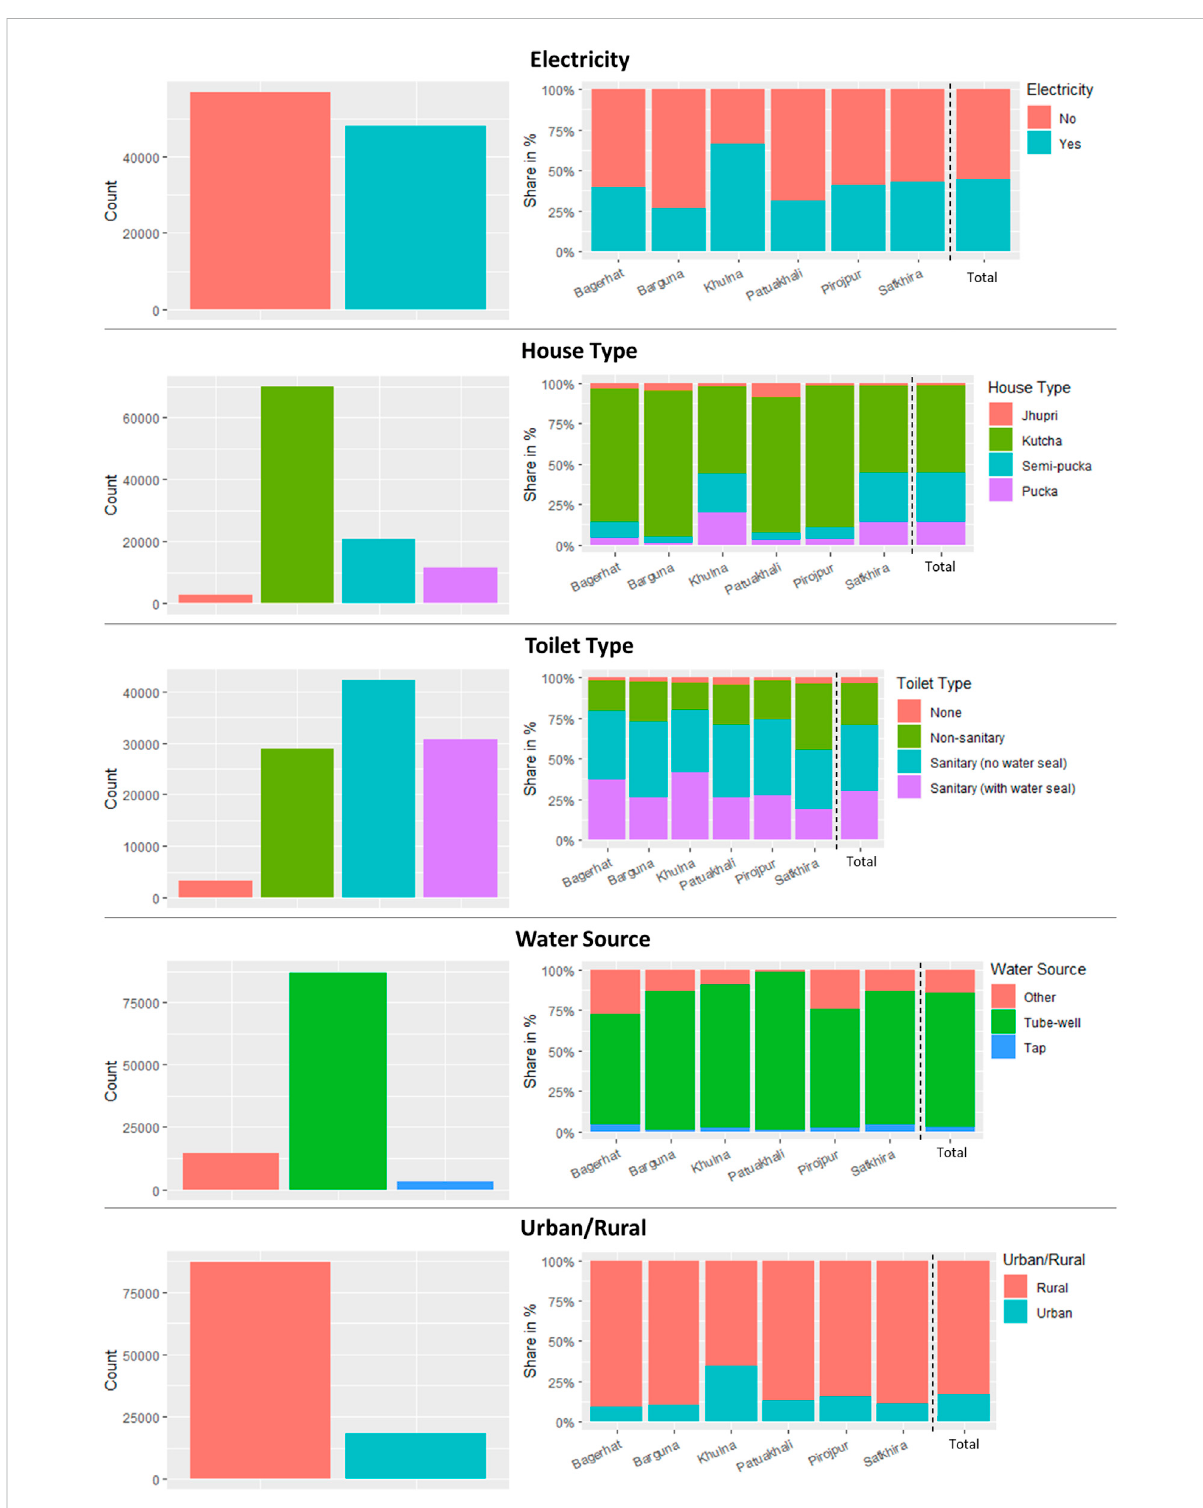
FIGURE 4 Modelled potentially fl ooded households by variable in aggregate (left) and proportional by district